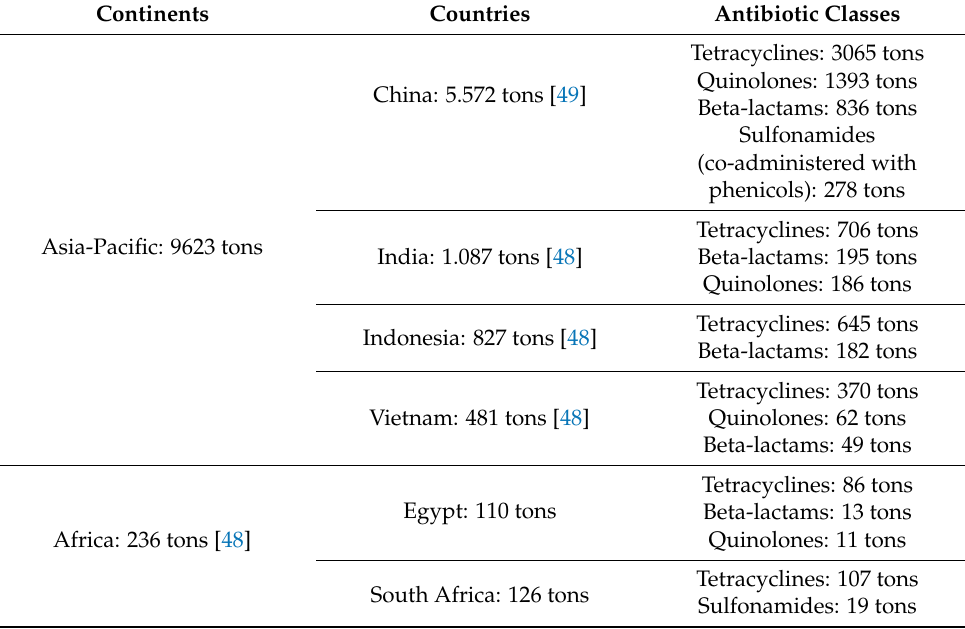
Table 3. Antibiotics and their distribution in finfish aquaculture from different geographical